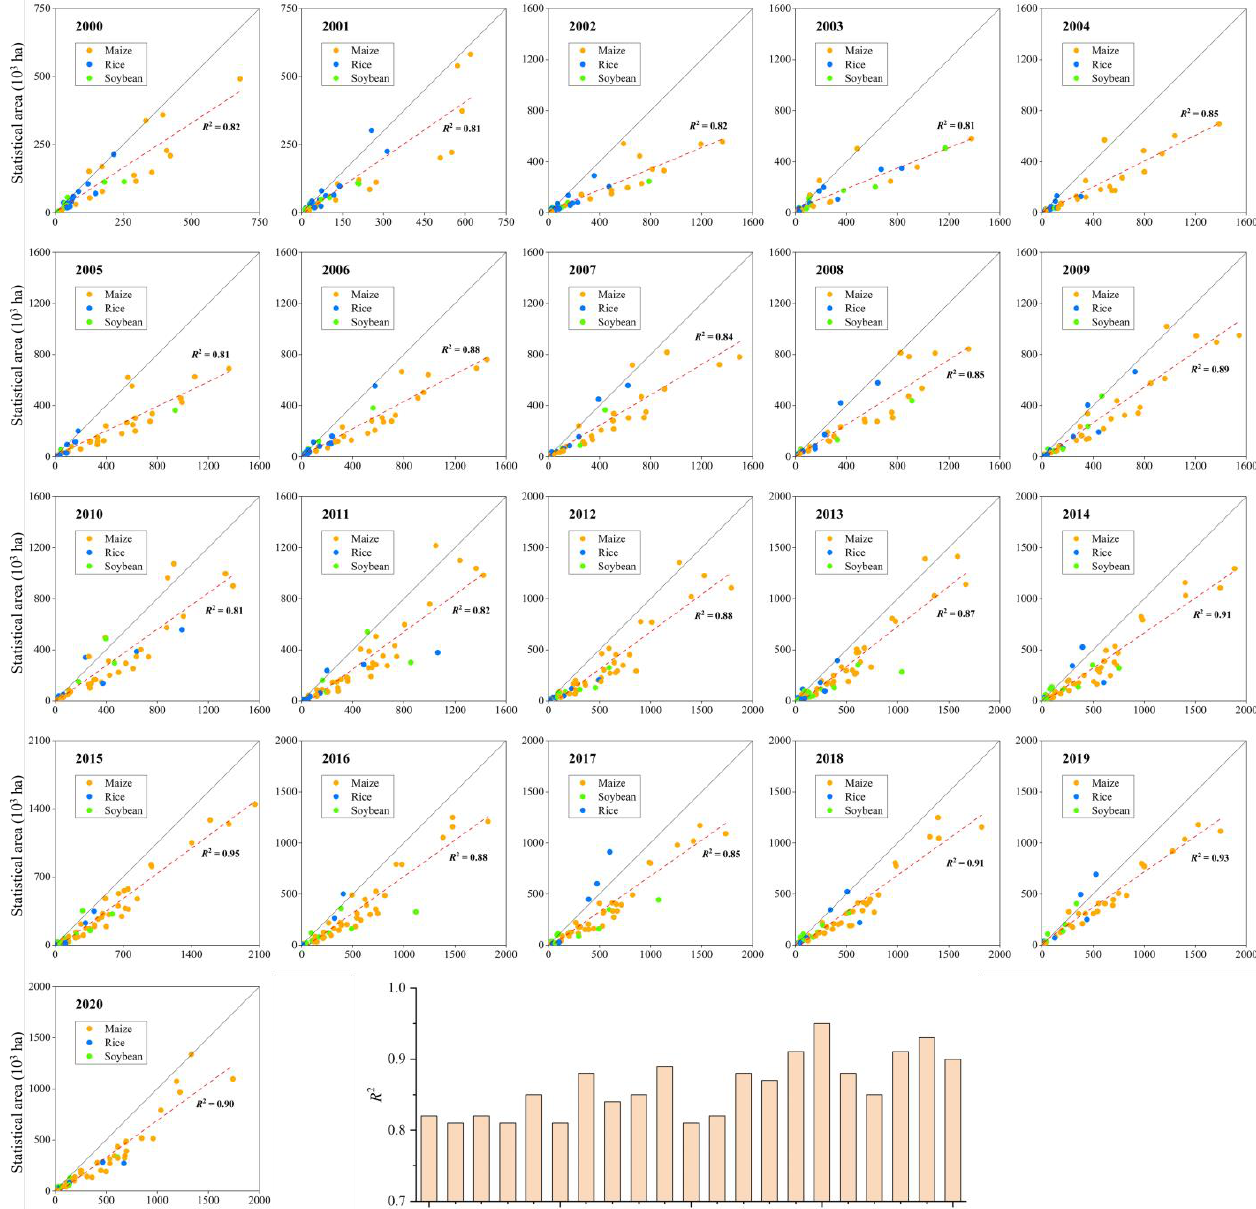
Figure 5. Comparison of annual mapped crop area and municipal-level statistical area in the NEC from 2000 to 2020.